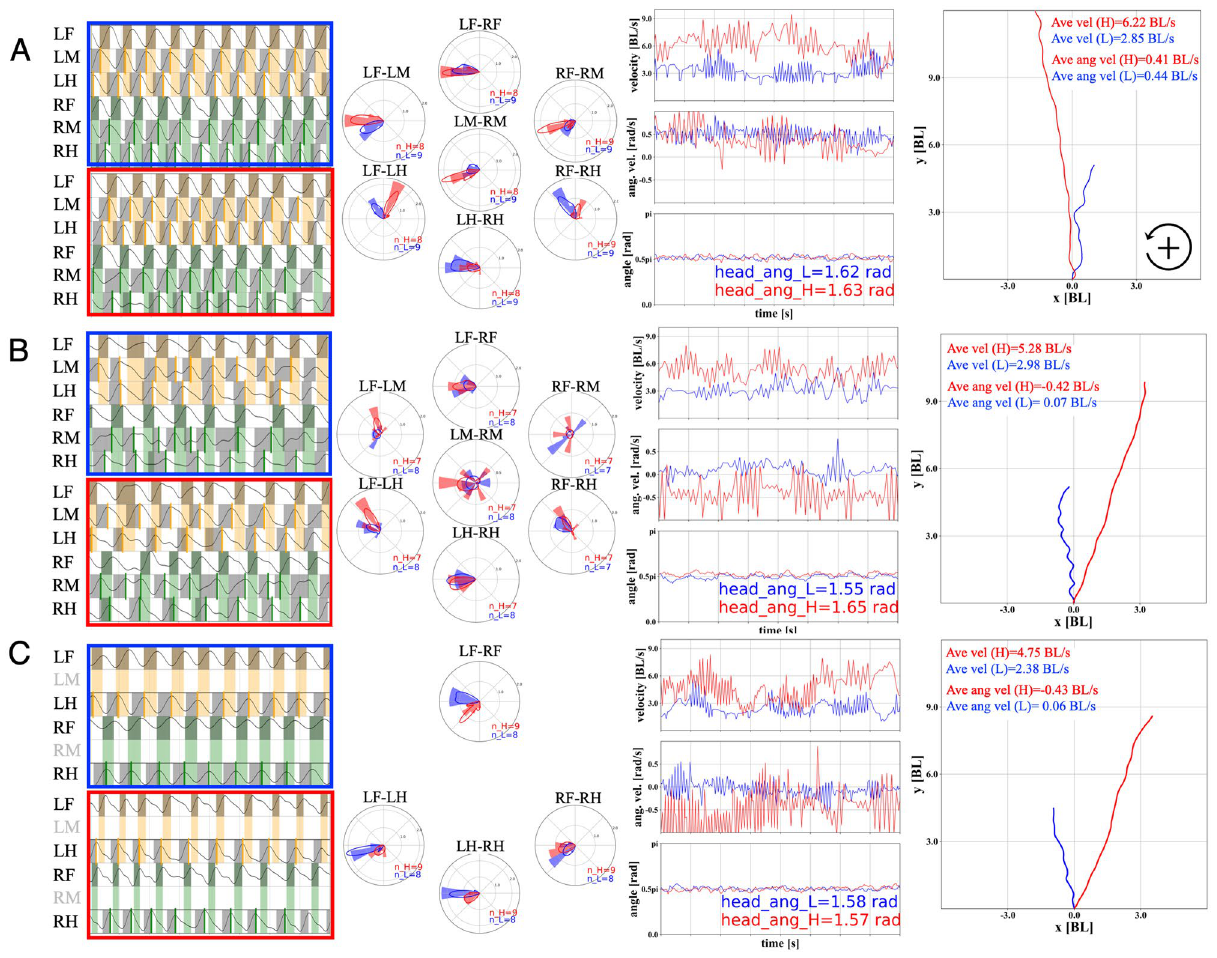
Figure 1. Gait pattern of the cricket (all data in 2 s intervals, blue and red colours represent gait data of low and high walking velocities, respectively). ( A ) Intact, blue = 2.85 BL(Body Length)/s, red = 6.22 BL/s; ( B ) Both middle legs amputated at the femur-tibial (FTi) joints, blue = 2.98 BL/s, red = 5.28 BL/s; and C . Both middle legs amputated at the coxatrochanteral joint (CTr) joints, blue = 2.38 BL/s, red = 4.75 BL/s. The far left panels show gait diagrams in walk, representative of each condition. The black lines show normalized leg joint trajectory of each leg estimated by DeepLabCut. The grey coloured region indicates swing phase (recovery stroke) periods, in which a leg moves forward. The orange and green coloured region indicate the swing phase of LF and RF legs. Bold lines (LM and LH: orange, RM and RH: green) on the gait diagrams show the timing of foot contact on legs for visibility. The second panels from the left show phase difference between the foot contact timings of legs using circular histogram and kernel density estimation (KDE) plots (left top: LF-LM, left bottom: LF-LH, centre top: LF-RF, centre middle: LM-RM, centre bottom: LH-RH, right top: RF-RM, right bottom: RF-RH). The third panels from the left show measured walking velocities [BL/s] in the walking direction (top), angular velocities [rad/s] of body rotation in the yaw axis (middle), and head angles θ cricket head [rad] (bottom) during walking. The far right panels show walking trajectories in the x - y plane [BL], which are integrated over the 2 s from the origin (0, 0) by using velocity, angular velocity, and body angle data for each